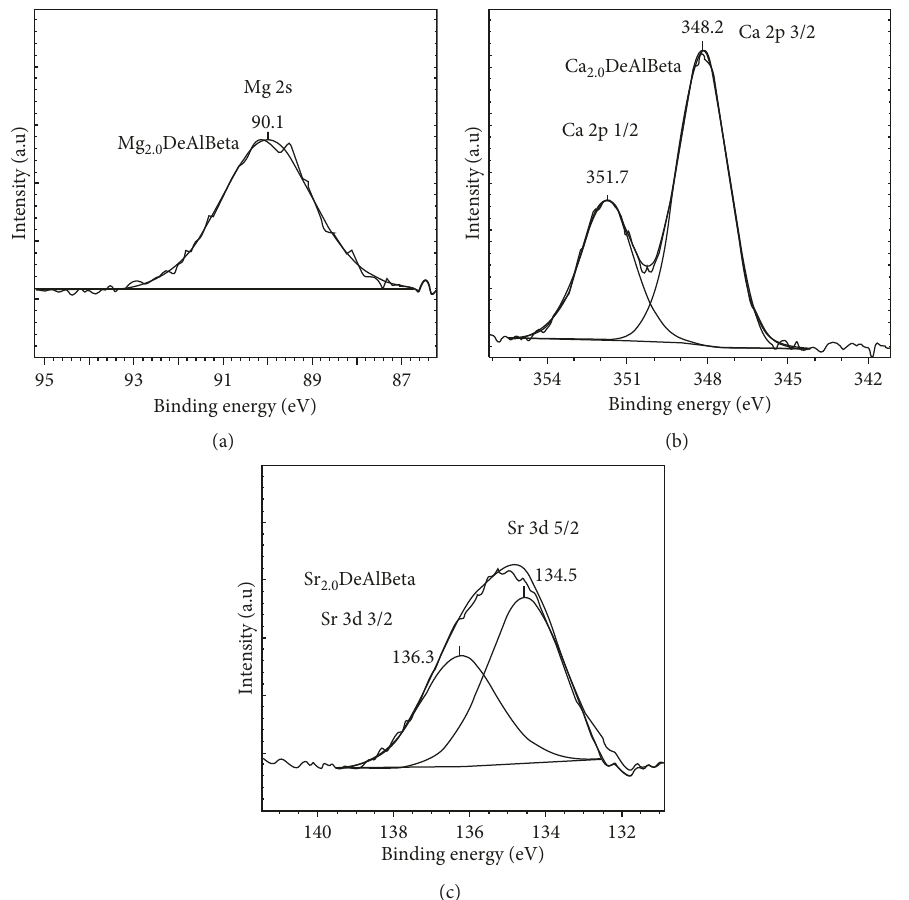
Figure 8: X-ray photoelectron spectra recorded at room temperature for (a) Mg 2s of Mg 3d of Sr 2.0 DeAlBeta.